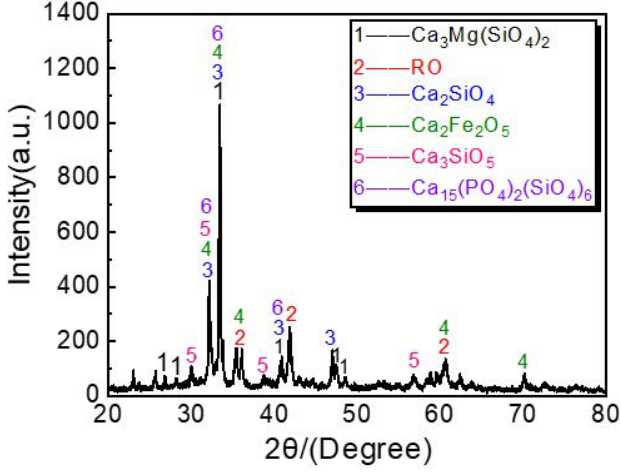
Figure 4. XRD analysis result of dephosphorization slag at 1405 °C.